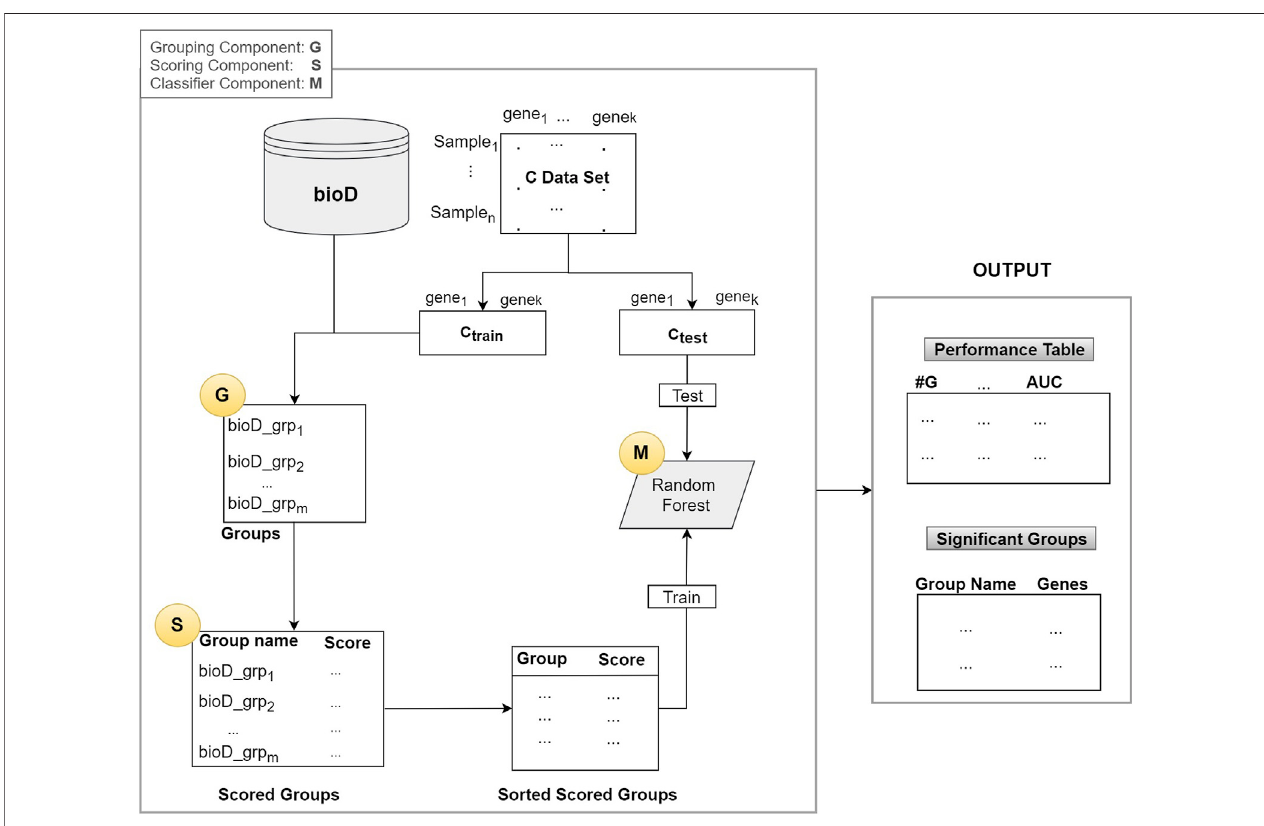
FIGURE 2 | The general integrative approach that is based on grouping and scoring/ranking.